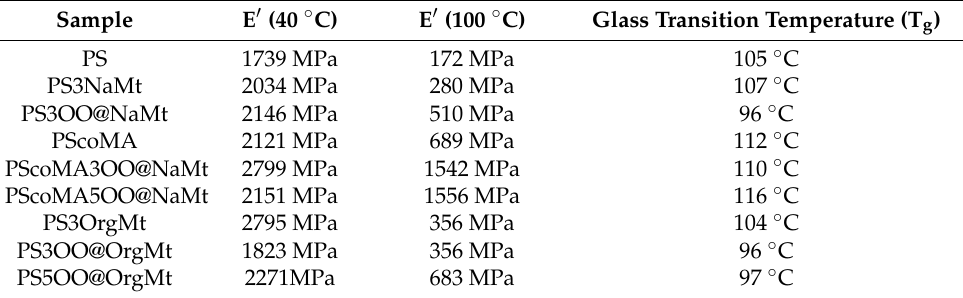
Table 3. Storage modulus (at 40 °C and 100 °C) and T g values of all the tested films.